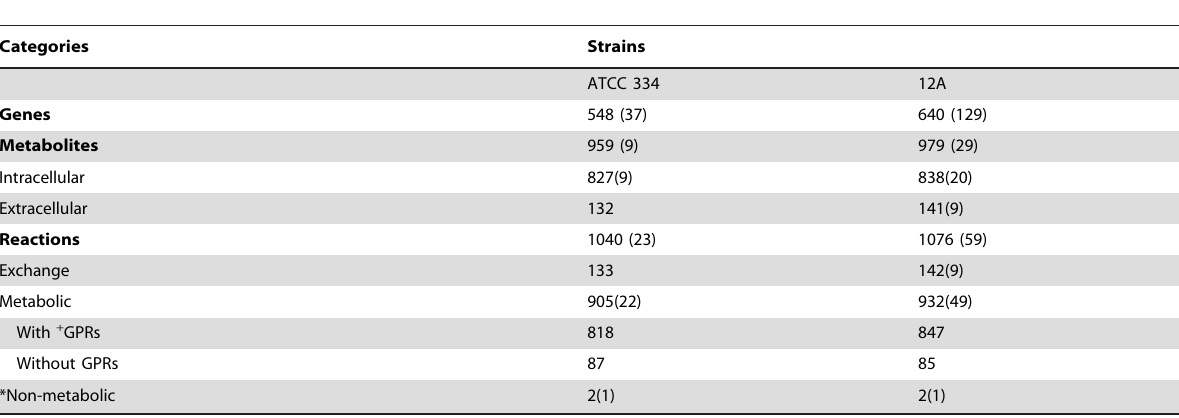
Table 2. Overview of metabolic models of L. casei 12A and ATCC